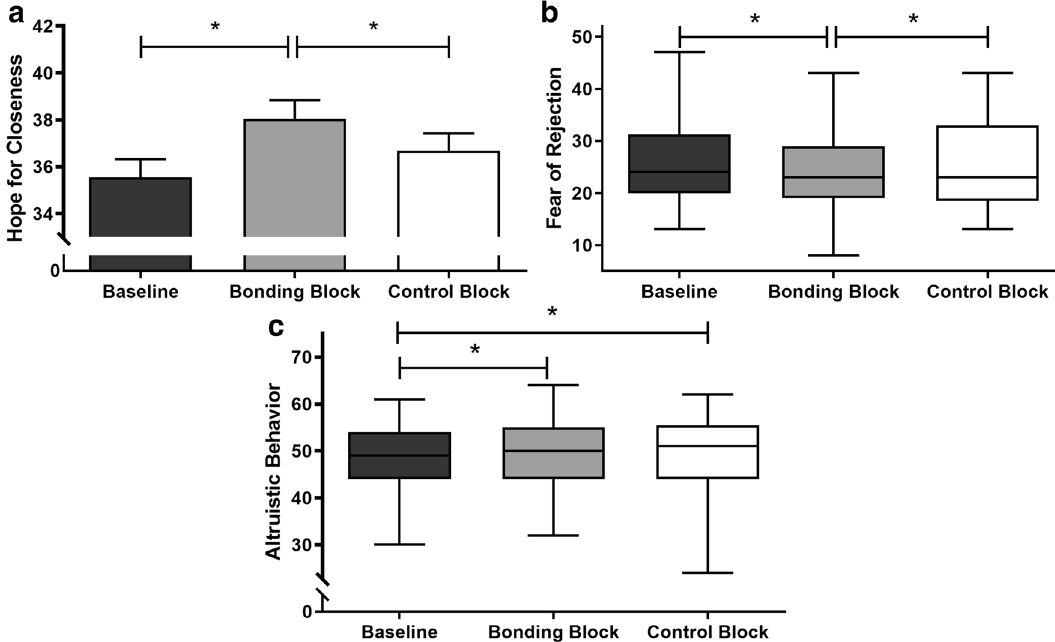
Figure 8. Mood state scores in study 2. Note ( a ) Self-reported hope for closeness assessed before (baseline) and after bonding and control blocks. Bonding pictures promoted greater hope for closeness when compared to baseline and to control block levels. Error bars indicate standard errors. ( b ) Self-reported fear of rejection assessed before (baseline) and after bonding and control blocks. Bonding pictures promoted lower fear of rejection when compared to baseline and to control block levels. Box extends from the 25th to 75th percentiles (interquartile range) and the error bars indicate minimum and maximum values. ( c ) Altruistic behavior assessed before (baseline) and after bonding and control blocks. Bonding and control pictures promoted greater altruistic behavior when compared to baseline. Box extends from the 25th to 75th percentiles (interquartile range) and the error bars indicate minimum and maximum values. *p <